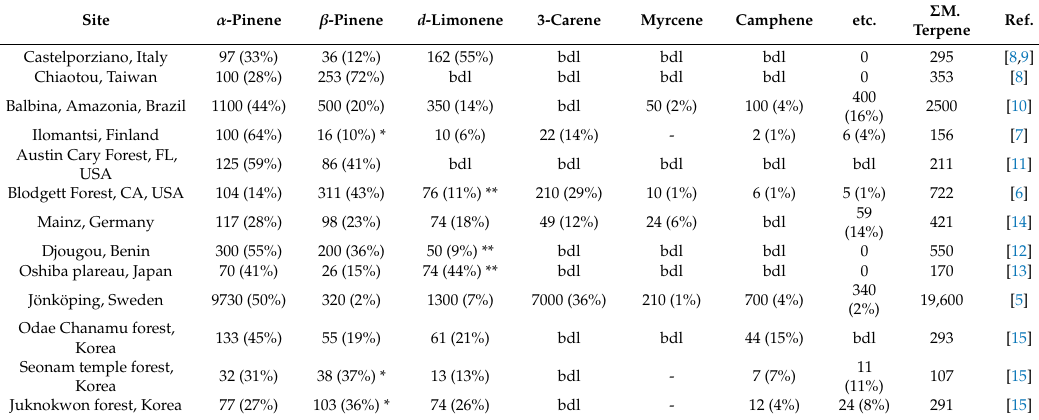
Table 1. Comparison of concentration levels (pptv) and composition ratios (%) of monoterpene compounds emitted from forests in di ff erent studies. Site α -Pinene β -Pinene d -Limonene 3-Carene Myrcene Camphene